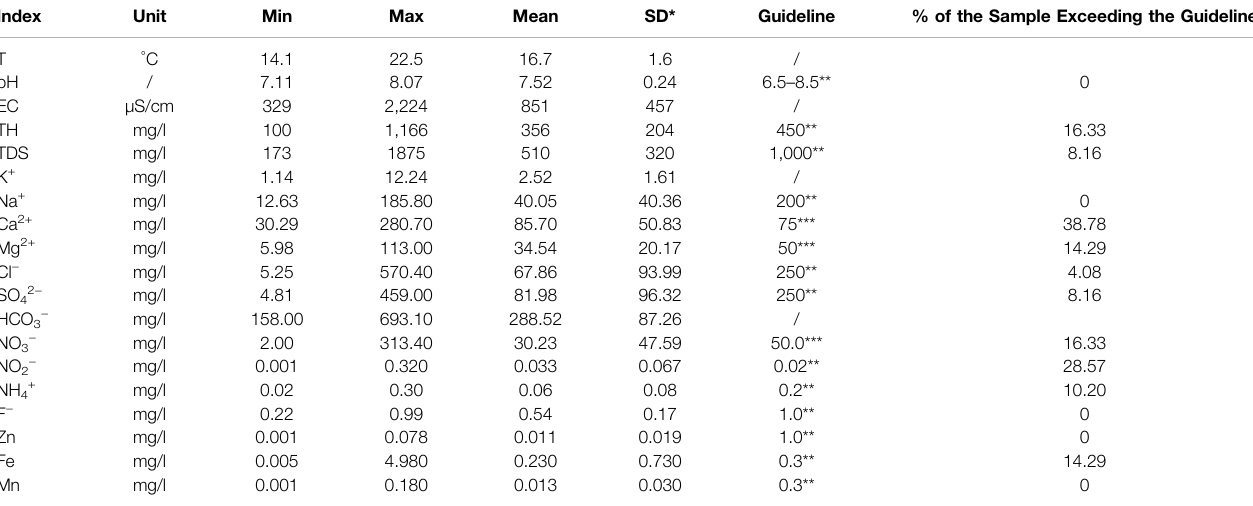
TABLE 2 | Statistical analysis of groundwater quality parameters and drinking water